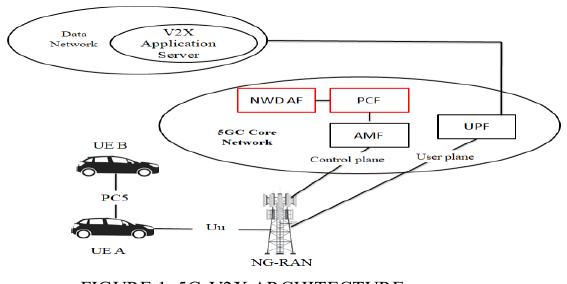
FIGURE 1. 5G-V2X